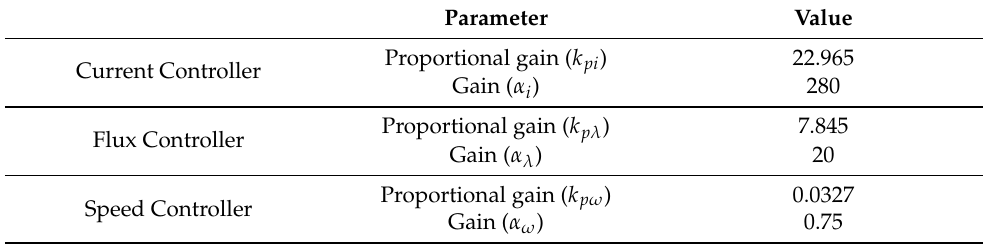
Table 2. Parameter design for system controllers.